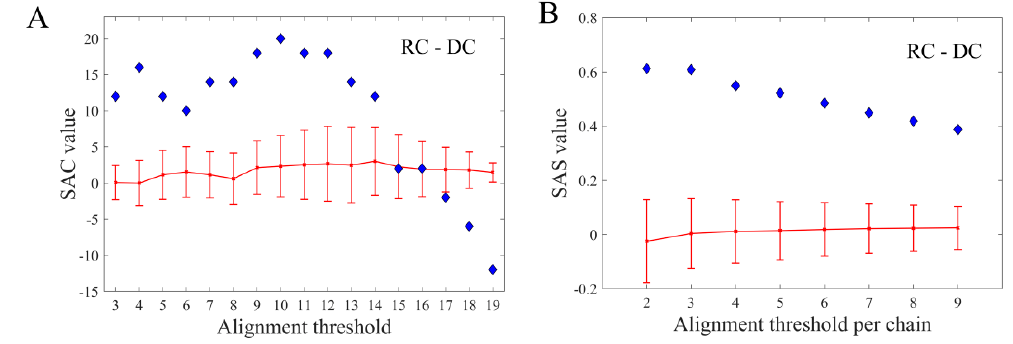
Figure 6. ( A ) The plot showing the difference between SAC and ( B ) SAS values associated with hits on the reverse and direct DNA strand of the E. coli genome shown as a function of the increasing of hits per chain. number of hits per chain.